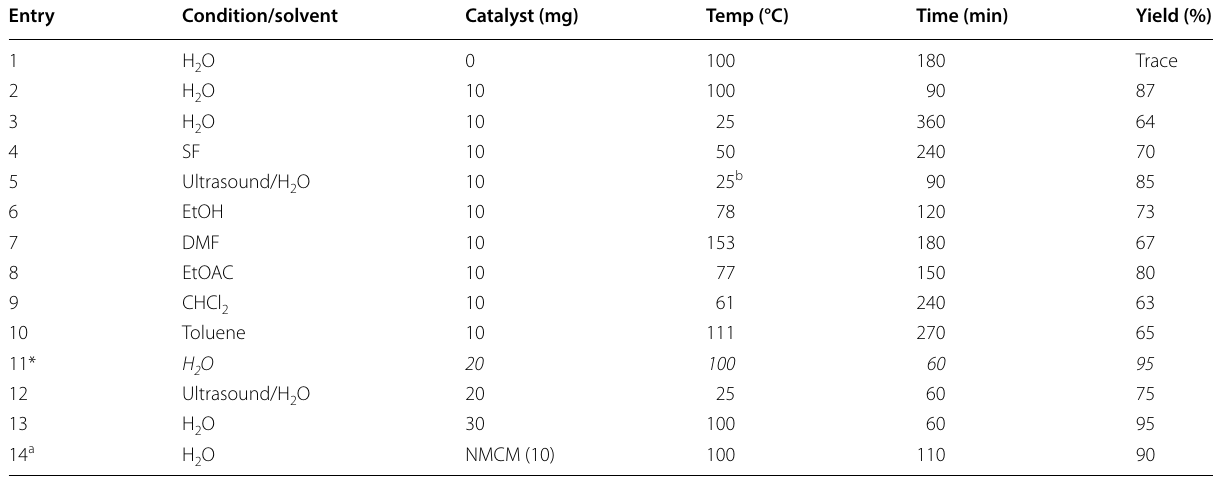
Table 1 Optimization of the reaction conditions (catalyst loading, solvent and temperature) for the synthesis of